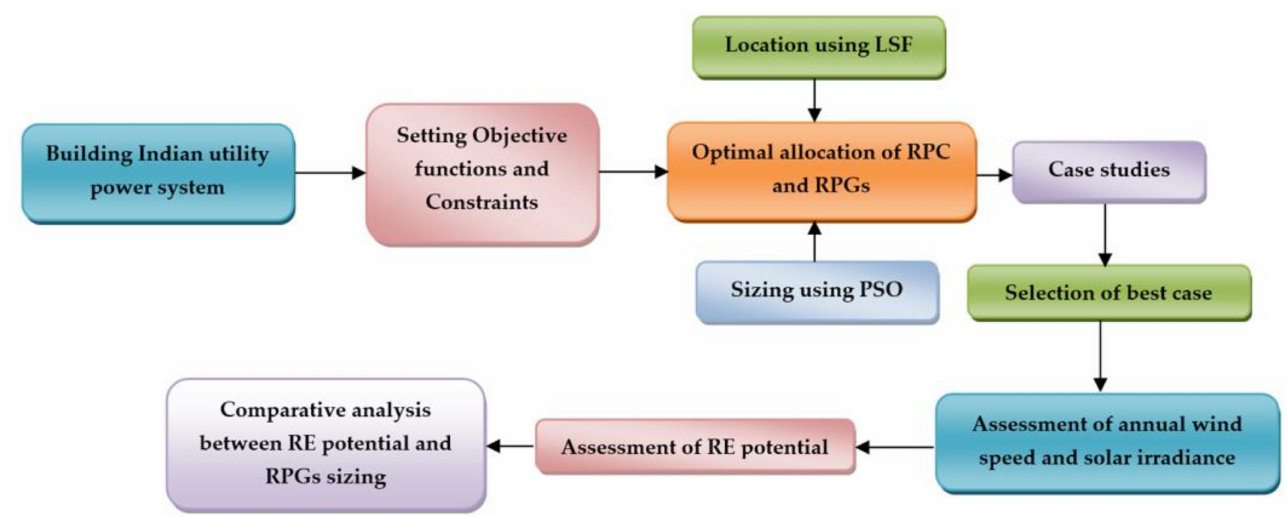
Figure 1. Overview of the proposed